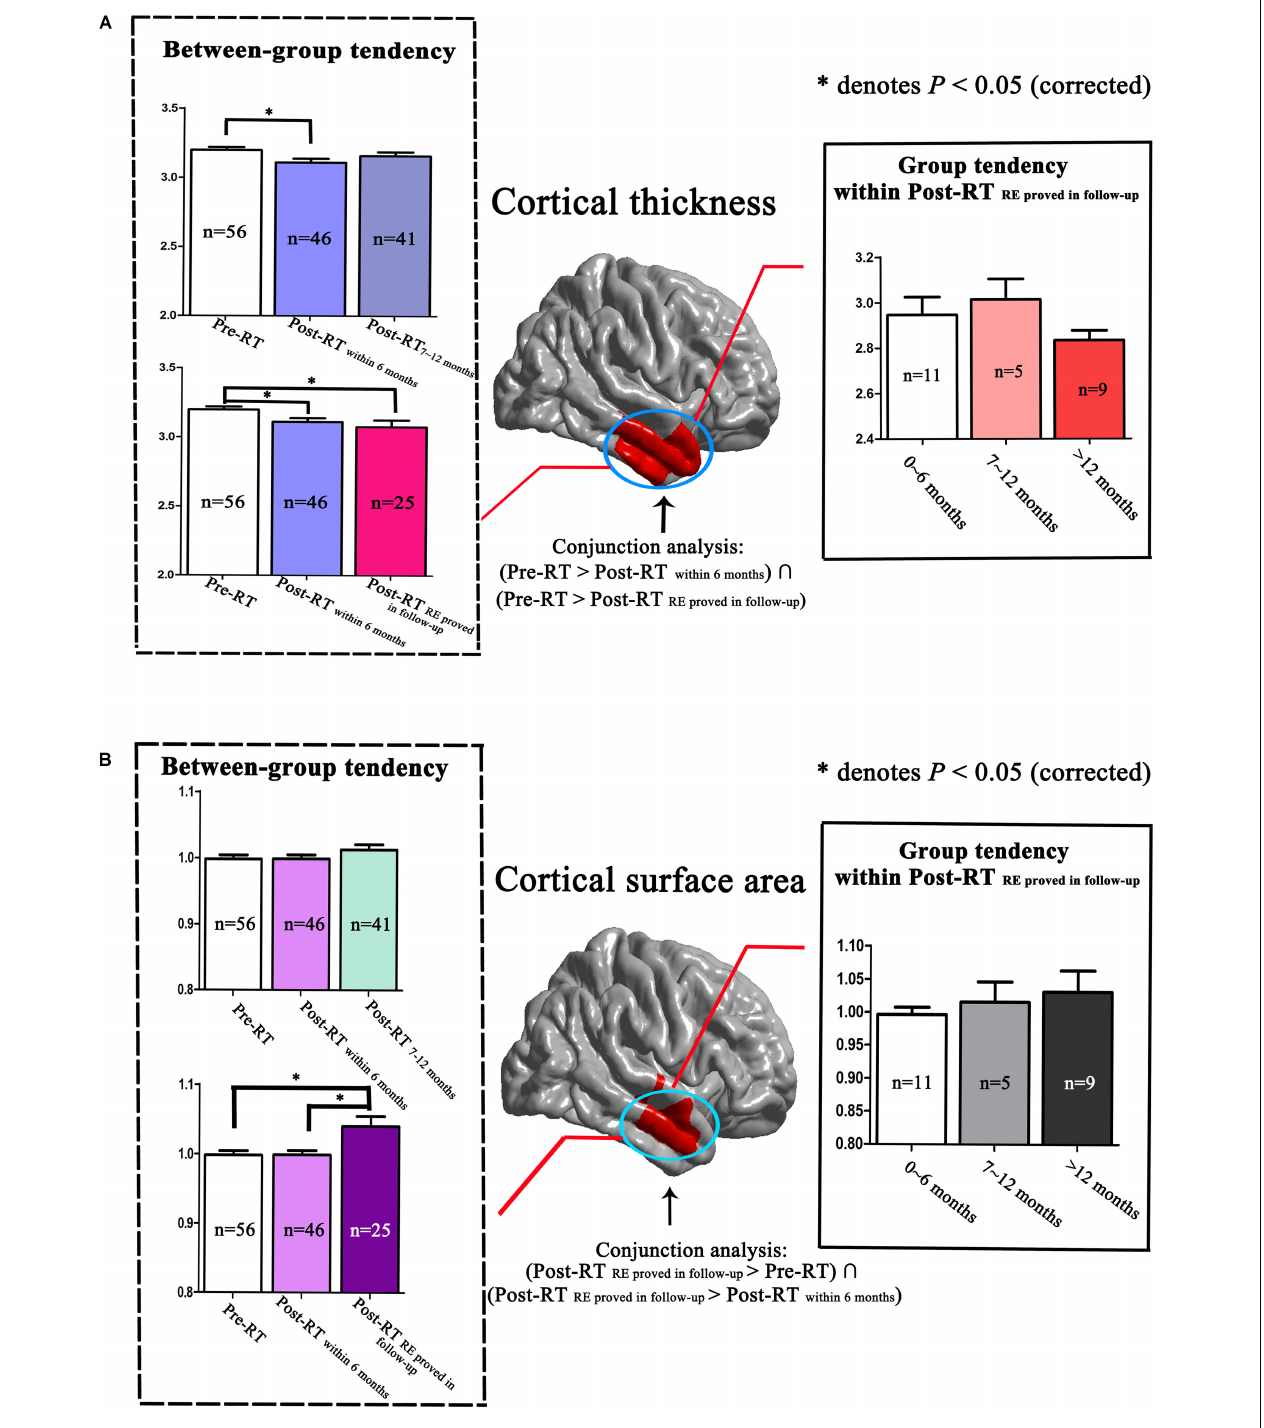
FIGURE 4 | Dynamic changing patterns of cortical thickness and cortical surface area. We performed a detailed analyses of data from locations within the right temporal lobe as indicated by the red color. Compared with Pre-RT patients, we found a significantly reduced cortical thickness in the right temporal lobes in the Post-RT within6 months patients, which was found to be normalized in the Post-RT 7 - 12 months patients. Similarly, the group tendencies in cortical thickness, both between-group (from Pre-RT group, Post-RT within6 months group to Post-RT REprovedinfollow - up group) and within the Post-RT REprovedinfollow - up group, were also nonspecific (A) . Interestingly, we observed a gradual increasing tendency in the cortical surface area of the right temporal lobe within the Post-RT REprovedinfollow - up group, consistent with the between-group findings, which showed a progressive increase in cortical surface area from the Pre-RT group, Post-RT within6 months group to the Post-RT REprovedinfollow - up group (B)